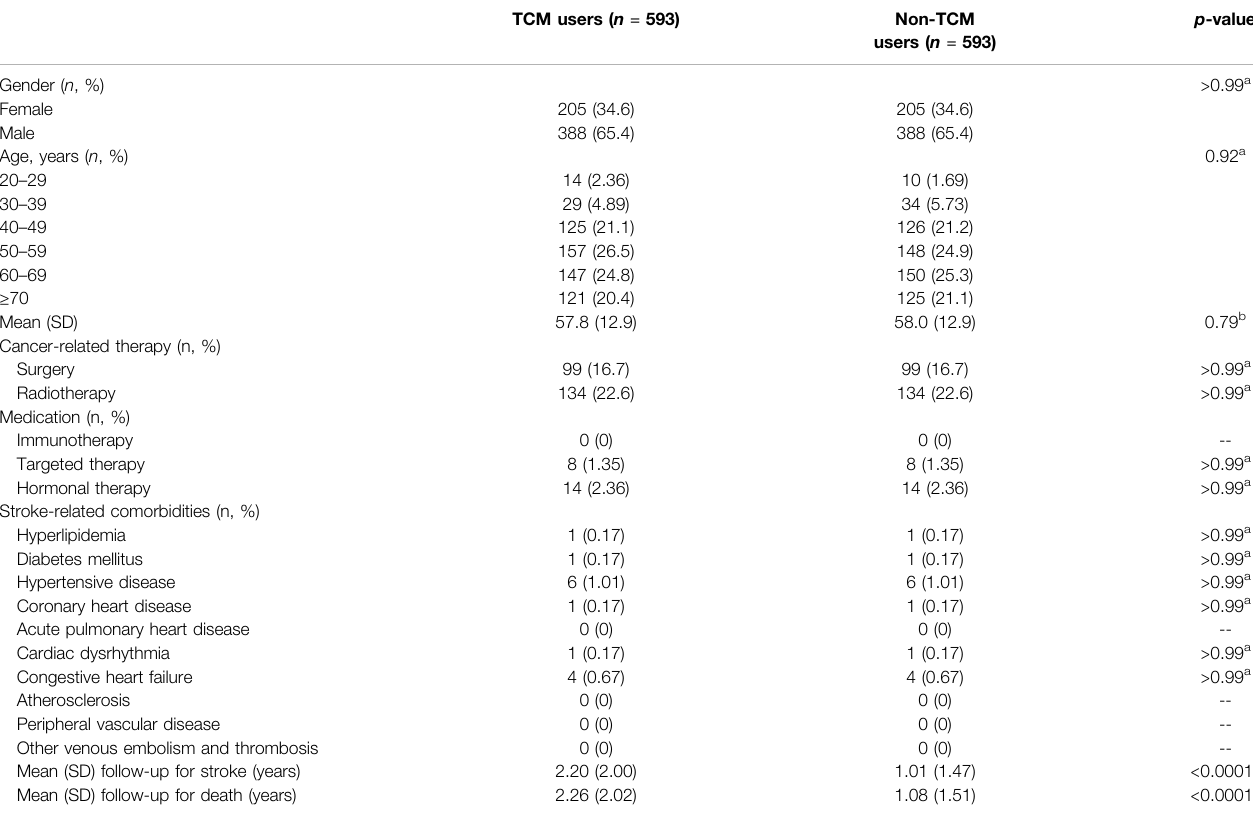
TABLE 1 | Baseline characteristics for TCM users and non-TCM users